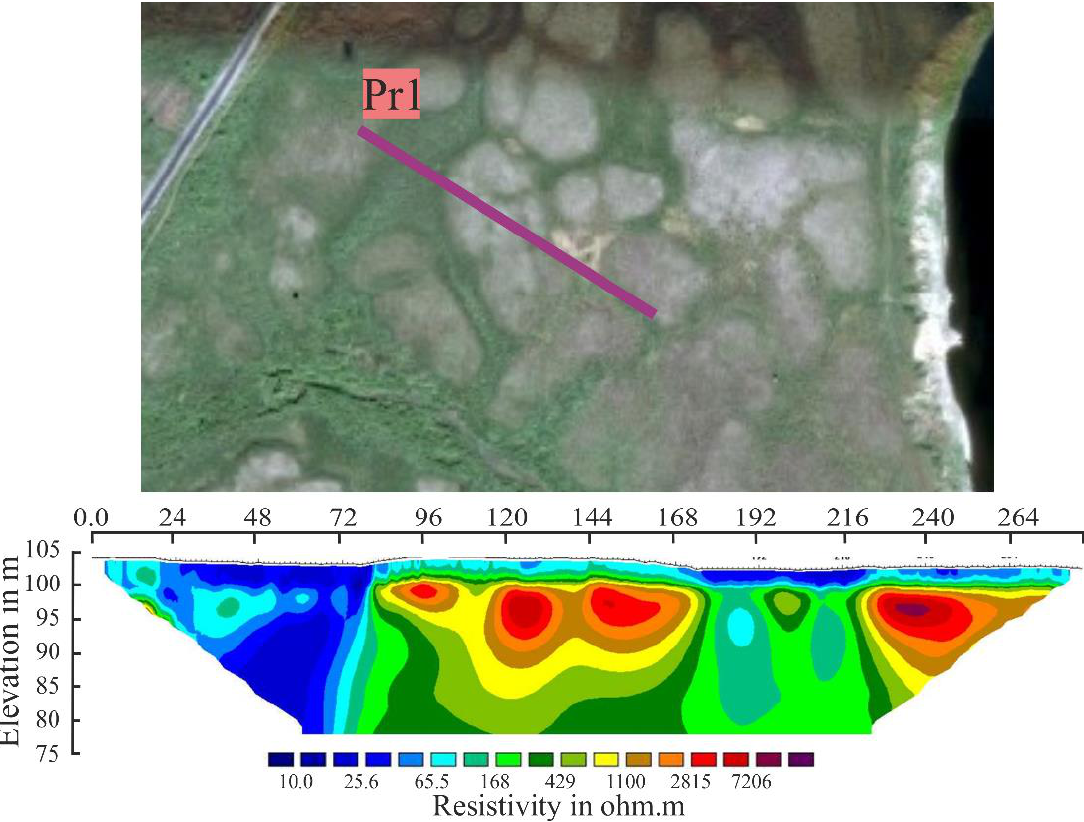
Figure 11. Results of ERT images in the area of Khanovey station (satellite image from [28]).